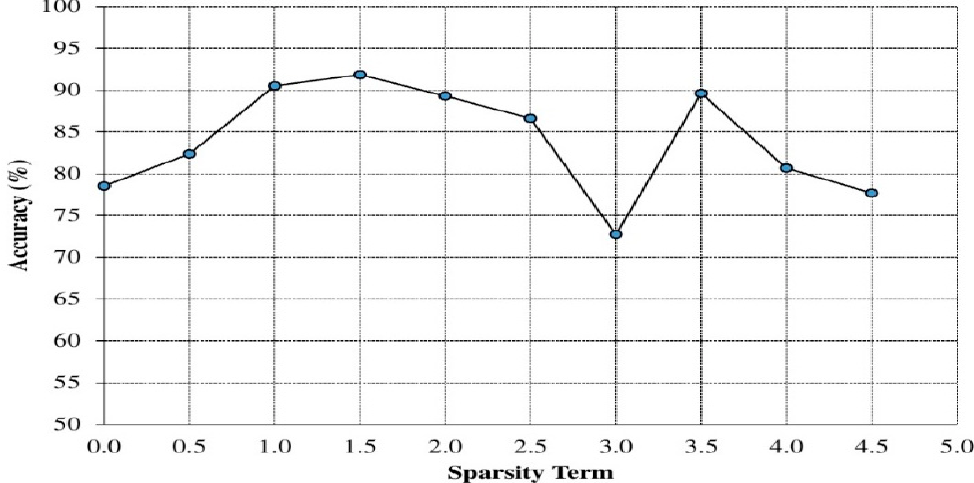
Figure 5. Influence of sparsity term on the performance results.